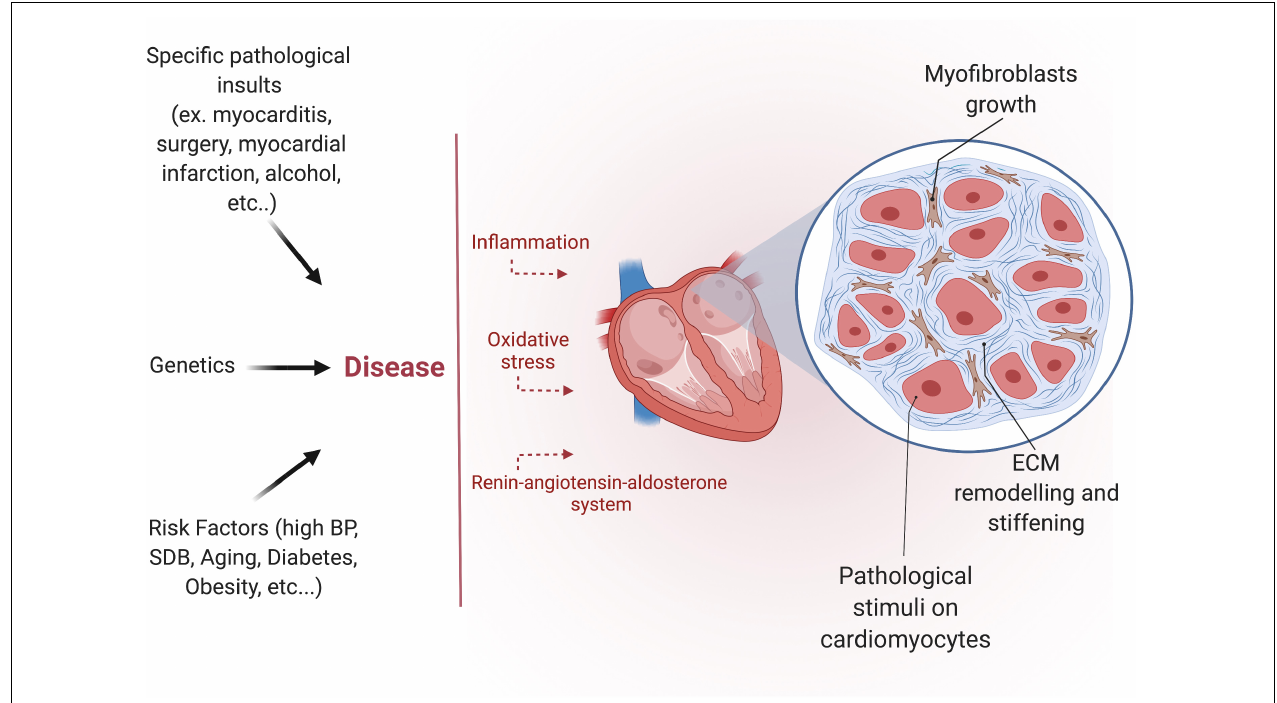
FIGURE 3 | Etiology of atrial fibrosis. Different pathological insults, risk factors, and certain genetic diseases induce atrial fibrosis. Atrial fibrosis is characterized by myofibroblast growth and extracellular matrix (ECM)